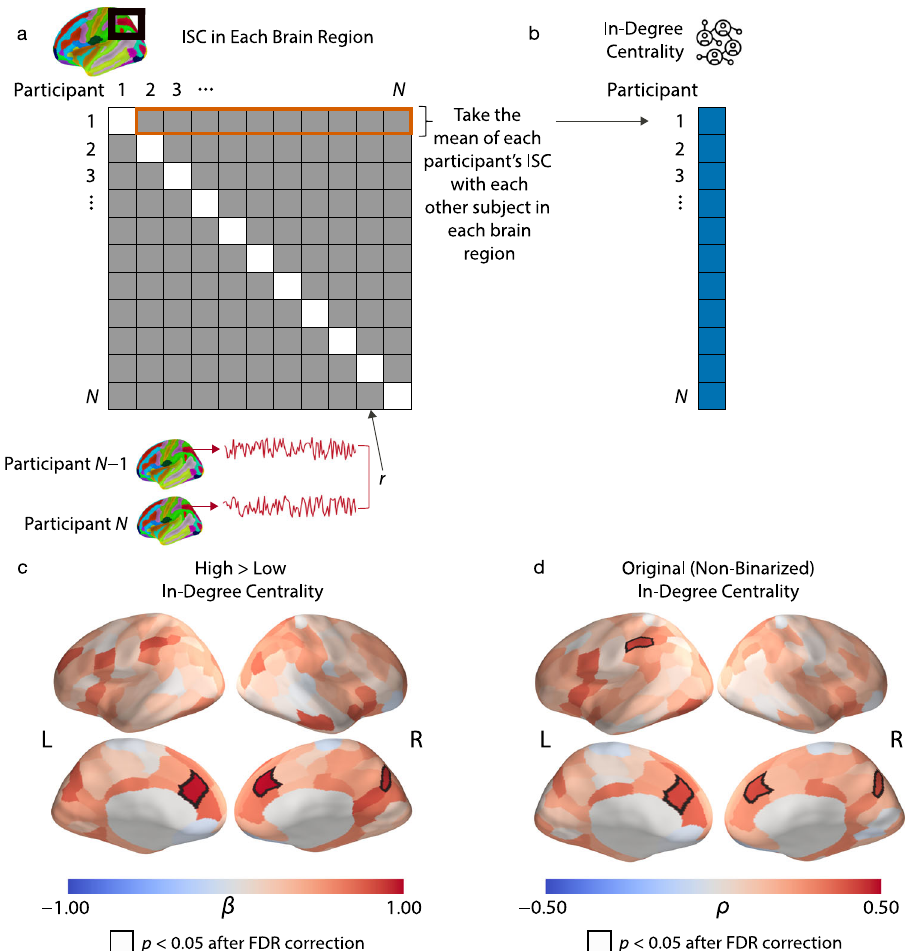
Fig. 2 Participant-level analysis. a Our approach for participant-level analysis. First, we Fisher z -transformed the dyad-level ISCs, which are encoded by a matrix of pairwise Pearson correlation coef fi cients (which we denote by r ). We then computed the mean of each participant ’ s ISC with each other participant. (In other words, we took the mean of each row of the matrix.) We performed the above calculations for each of the 214 brain regions. This yields one ISC value for each participant for each brain region. The ISC value encodes the mean similarity of the neural responses between the participant and each other participant in the corresponding brain region. b We tested for relationships between the participants ’ in-degree centralities and these participant-level ISC values in each brain region. c Our results that relate mean ISCs with the binarized in-degree centrality variable indicated that individuals with high in-degree centralities had much larger mean neural similarities with their peers in the bilateral DMPFC and precuneus than individuals with low in-degree centralities. d Our results that relate mean ISCs with the original (i.e., non-binarized) in-degree centrality values gave similar results as the analysis in ( c ). We found that the mean ISCs in the bilateral DMPFC, precuneus, and the superior parietal lobule were positively correlated with in- degree centrality. The quantity β denotes the standardized regression coef fi cient, and ρ denotes the Spearman rank correlation. All results are FDR- corrected at p < 0.05, which corresponds to an uncorrected p -value of 0.009 in ( c ) and an uncorrected p -value of 0.001 in ( d ). All of the reported p -values are two-tailed. Source data are provided as a Source Data fi false-discovery rate (FDR) correction to correct for multiple comparisons across brain regions. We found that high in-degree exhibited more typical neural responses than individuals with centrality was associated with larger mean neural similarity lower in-degree centralities. To do this, in each brain region, we with peers in the dorsomedial prefrontal cortex (DMPFC) bilat- erally (left DMPFC: β = 0.964, SE = 0.233, p corrected = 0.012, p uncorrected < 0.001; right DMPFC: β = 0.977, SE = 0.232, participant-level measure by calculating the mean Fisher z - p corrected = 0.012, p uncorrected < 0.001) and right transformed 39 ISC value for each participant with each other participant. This yields one ISC value for each individual for each brain region; this value encodes a mean similarity of the neural responses between the individual and all other individuals in the scatter plots to illustrate the relationships between the in-degree corresponding brain region (see Fig. 2a). After calculating these values, we fi t one generalized linear model (GLM) for each brain region with the ISC in the respective brain region as the depen- dent variable (which we transformed into z -scores to produce standardized coef fi cients) and the binarized in-degree centrality as the independent variable (see Fig. 2b). Finally, we employed